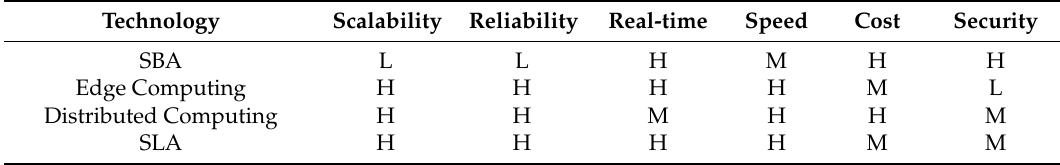
Table 2. Comparison of the performances for different emerging technologies in context to the performance metrics.